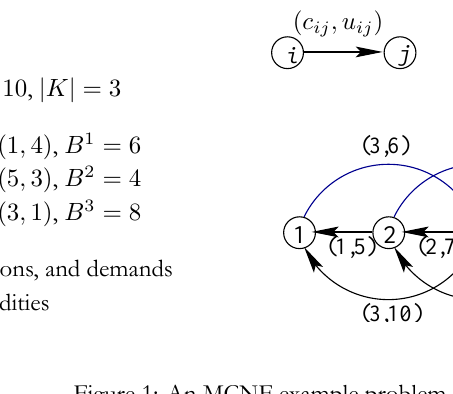
Figure 1: An MCNF example